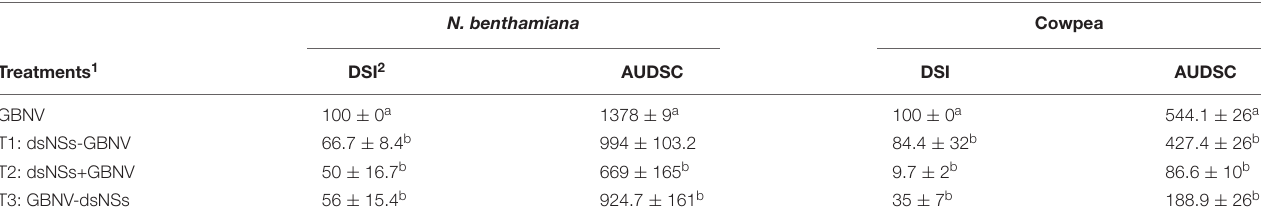
TABLE 2 | Effect of topically applied dsRNA of NSs gene of groundnut bud necrosis virus (GBNV) on the disease severity in Nicotiana benthamiana and cowpea cv. Pusa